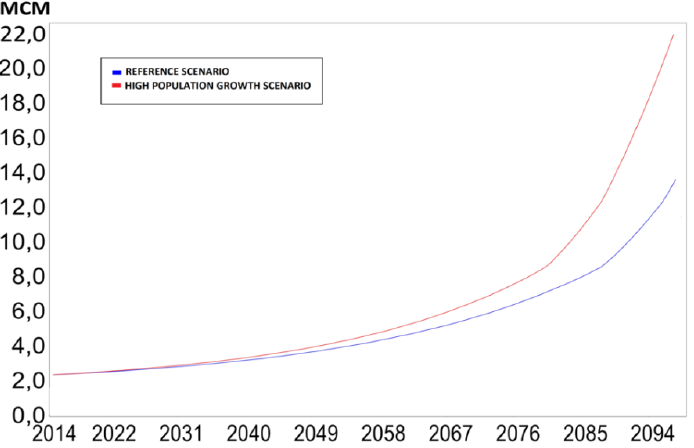
Figure 7. The unmet water demand for the reference scenario and high population growth